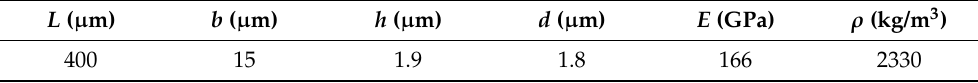
Table 1. Dimensions and material properties of the microbeam used for model validation.